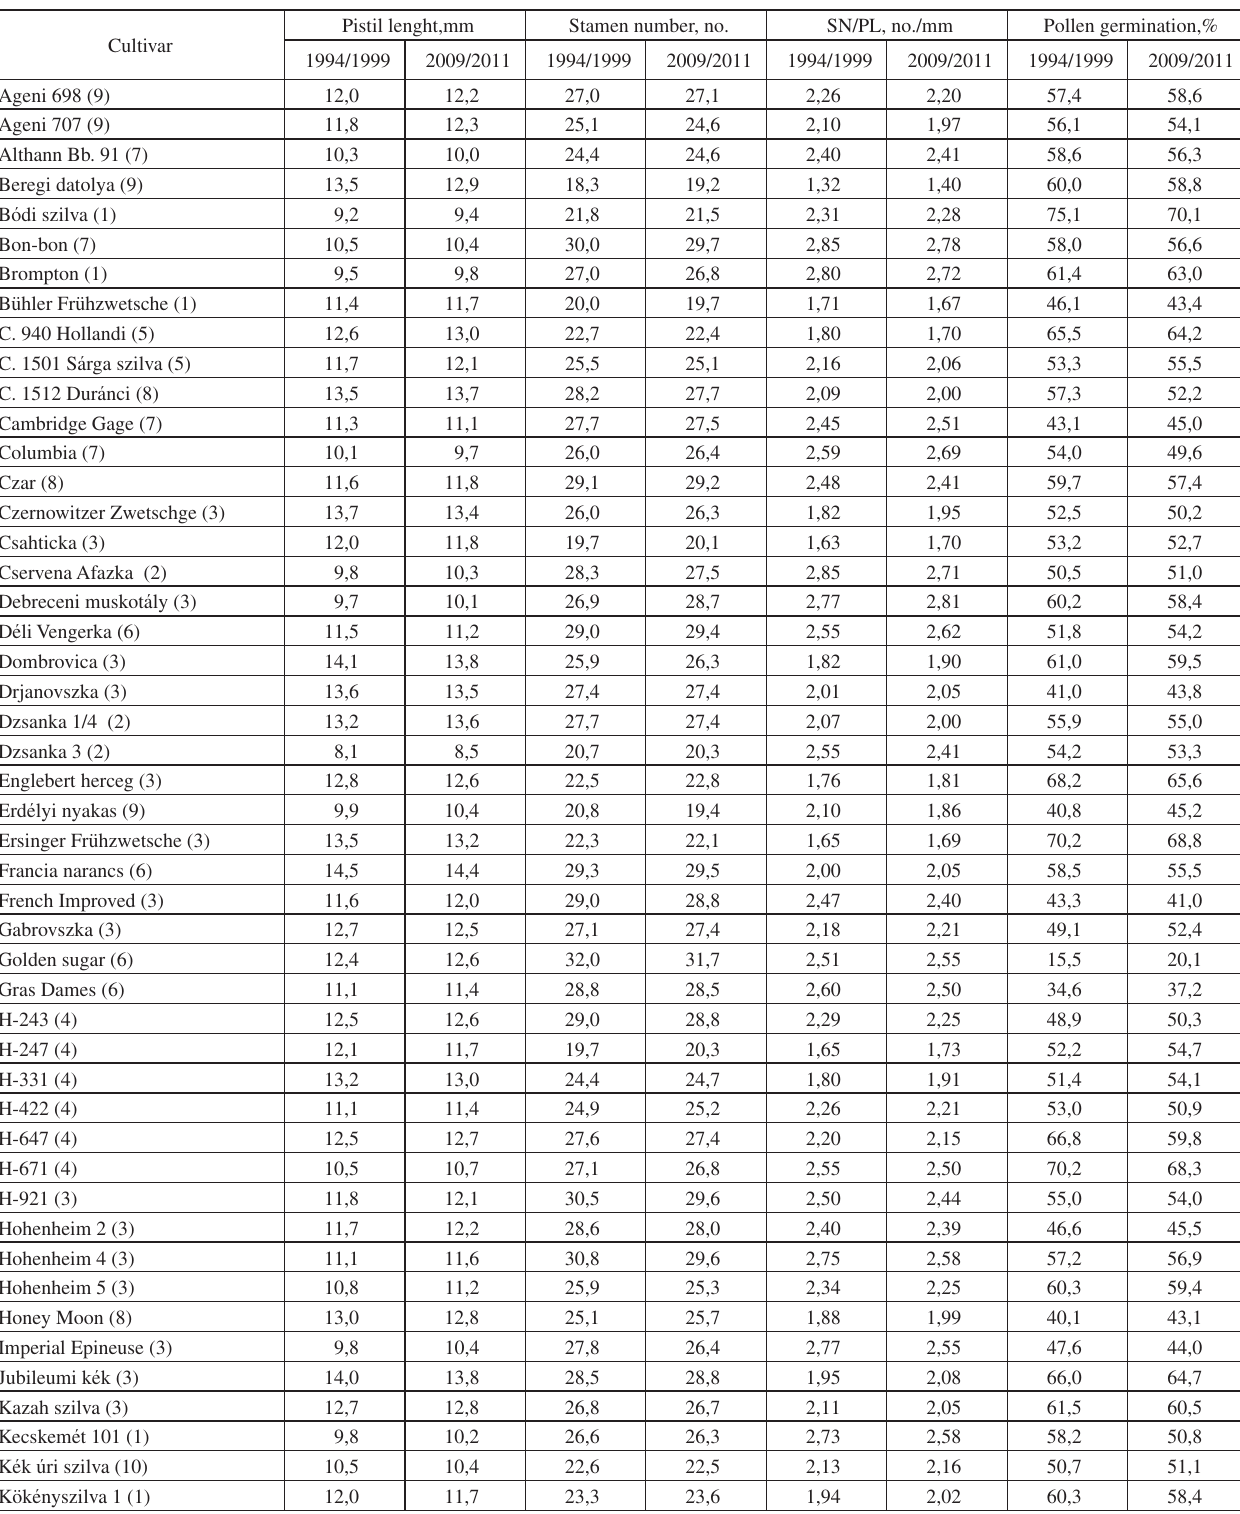
Table 3. Estimation of fl owers in Prunus cultivars (Cegléd)